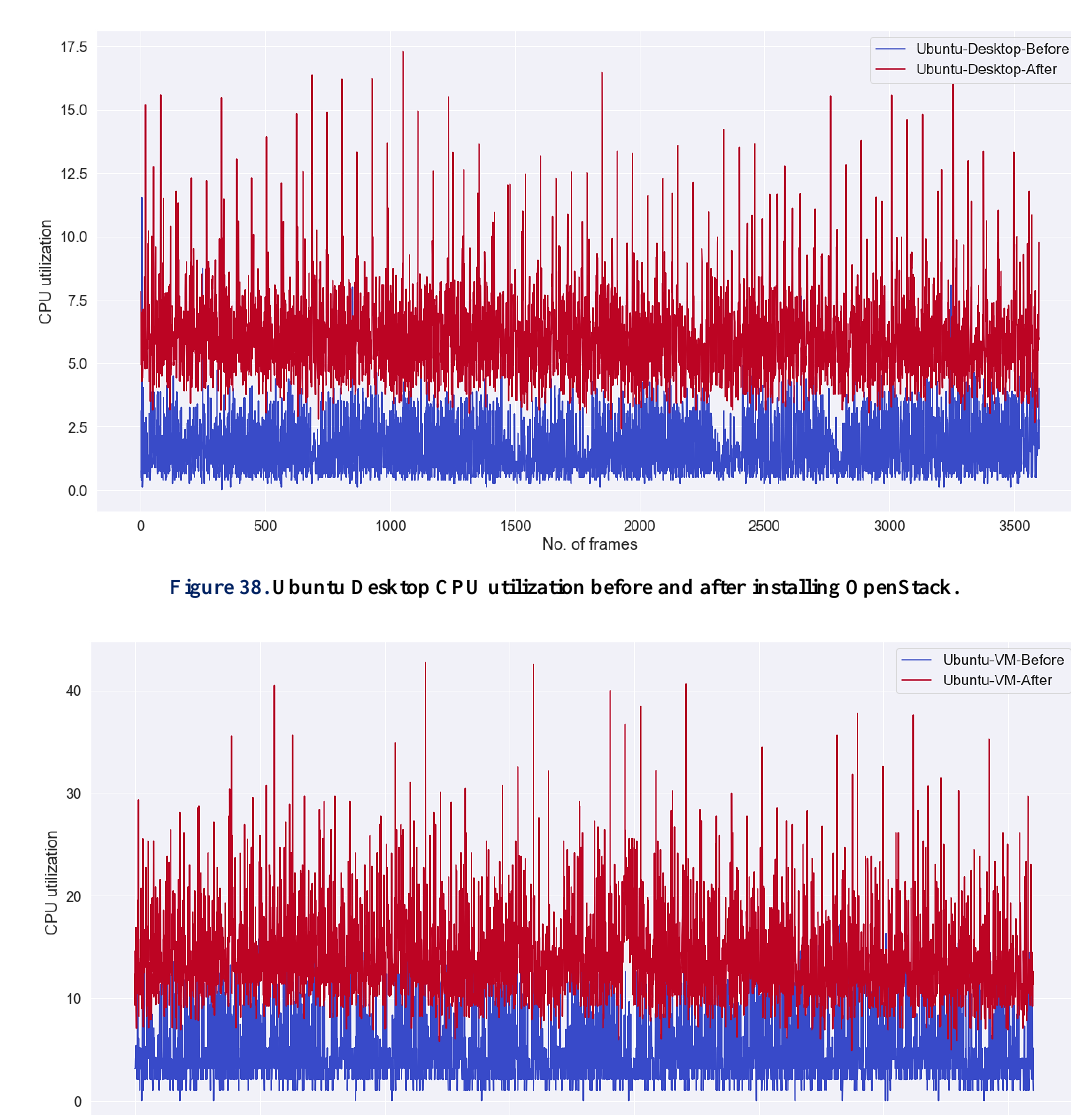
Figure 37. Ubuntu Server CPU utilization before and after installing OpenStack.